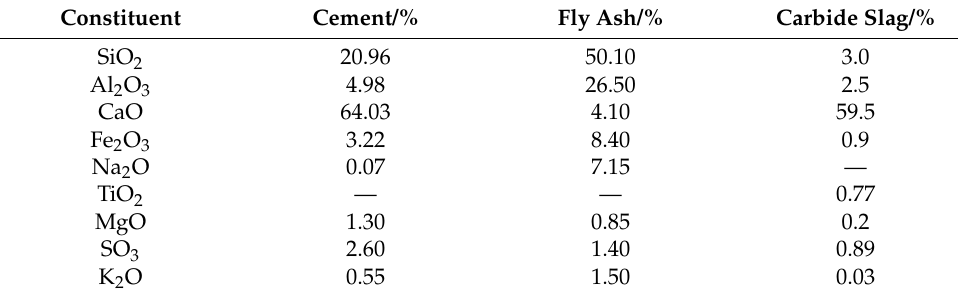
Table 2. Chemical compositions of major